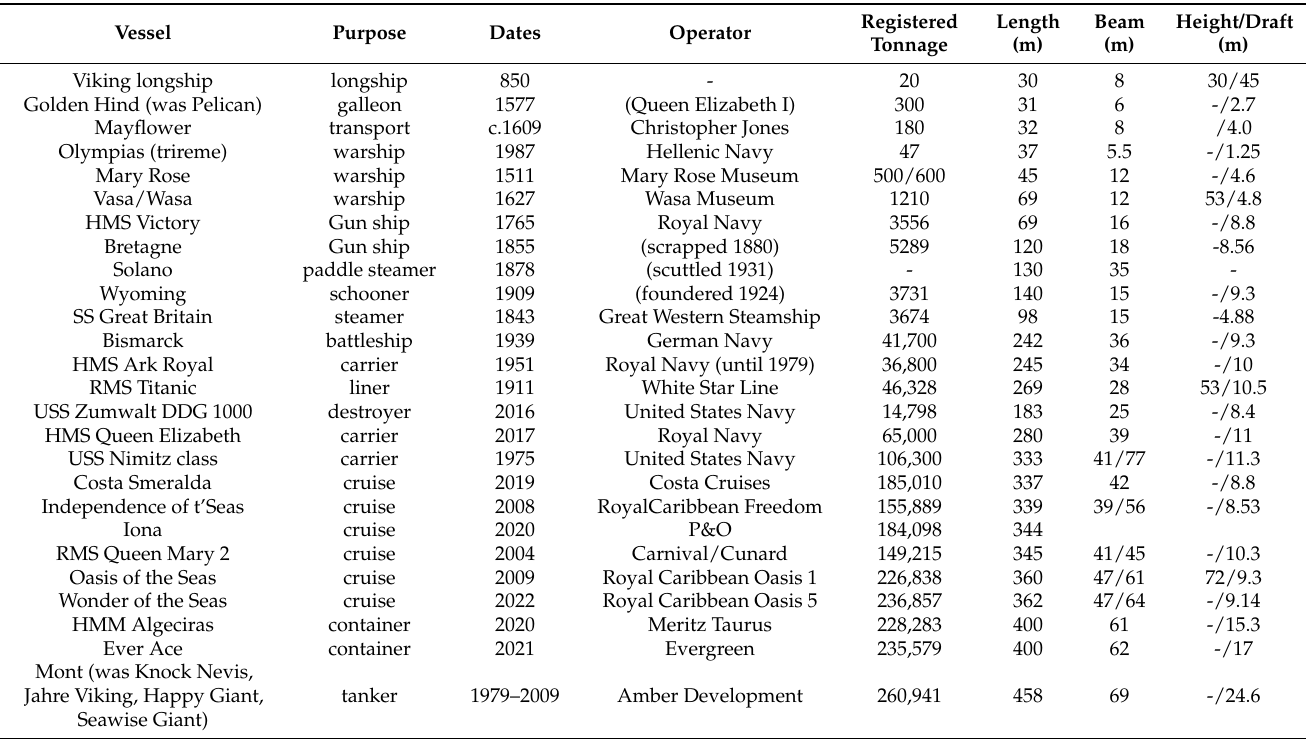
Table A1. A selection of historic, or large recent, ships ranked by